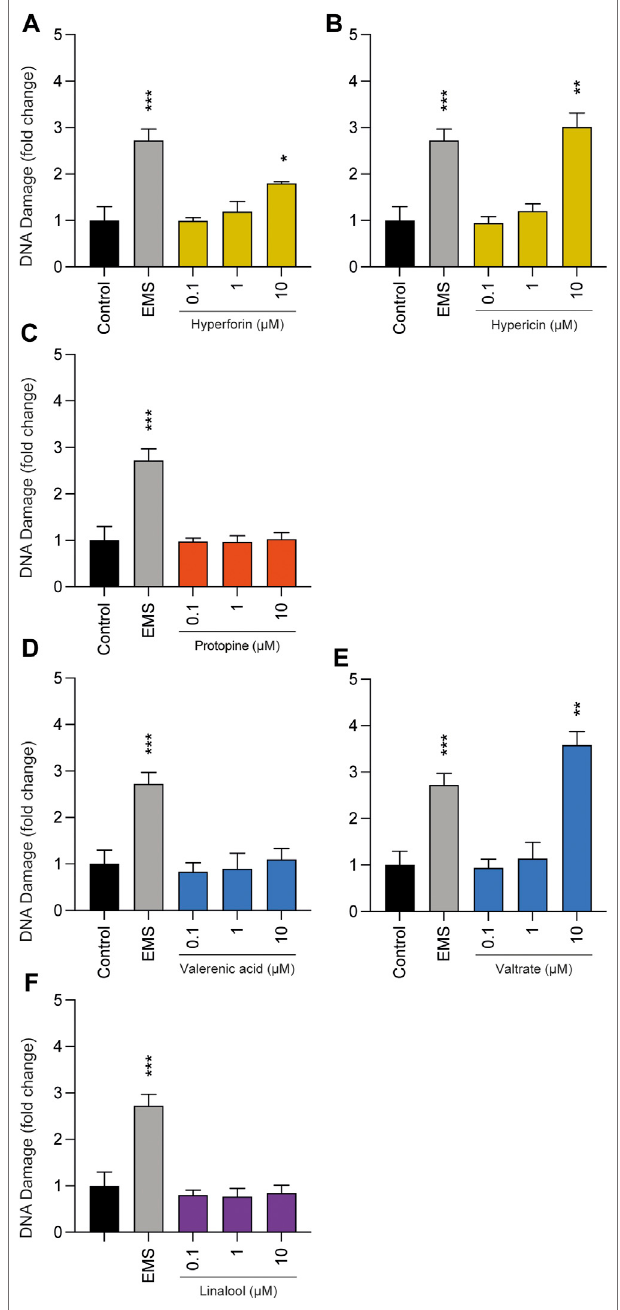
FIGURE 4 | Effects of phytochemicals (A) hyperforin, (B) hypericin, (C) protopine, (D) valerenic acid, (E) valtrate, and (F) linalool on tail DNA in undifferentiated BeWo b30 cells after exposure for 3 h. No signi fi cant genotoxic effects were observed at concentrations of 0.1 and 1 µM. Only the highest concentrations (10 µM) of hyperforin, hypericin, and valtrate led to increased DNA damage of BeWo b30 cells. Results were calculated as foldchangecomparedtotheuntreatedcontrol.Ethylmethanesulfonate(EMS, 3 mM) was used as a positive control ( n = 3).